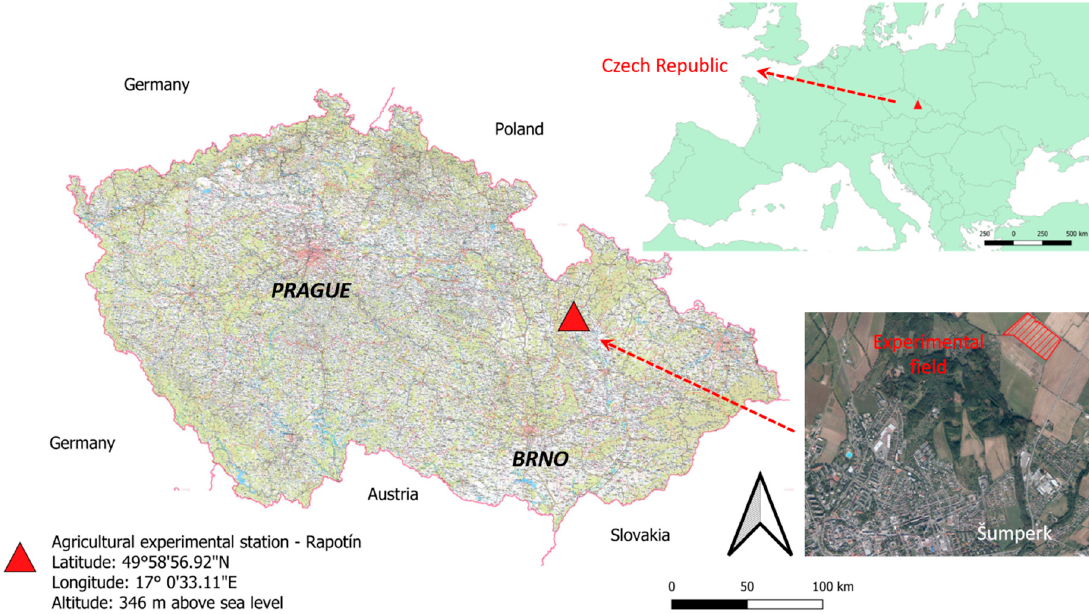
Figure 1. Localization of the field experiment within the Czech Republic.